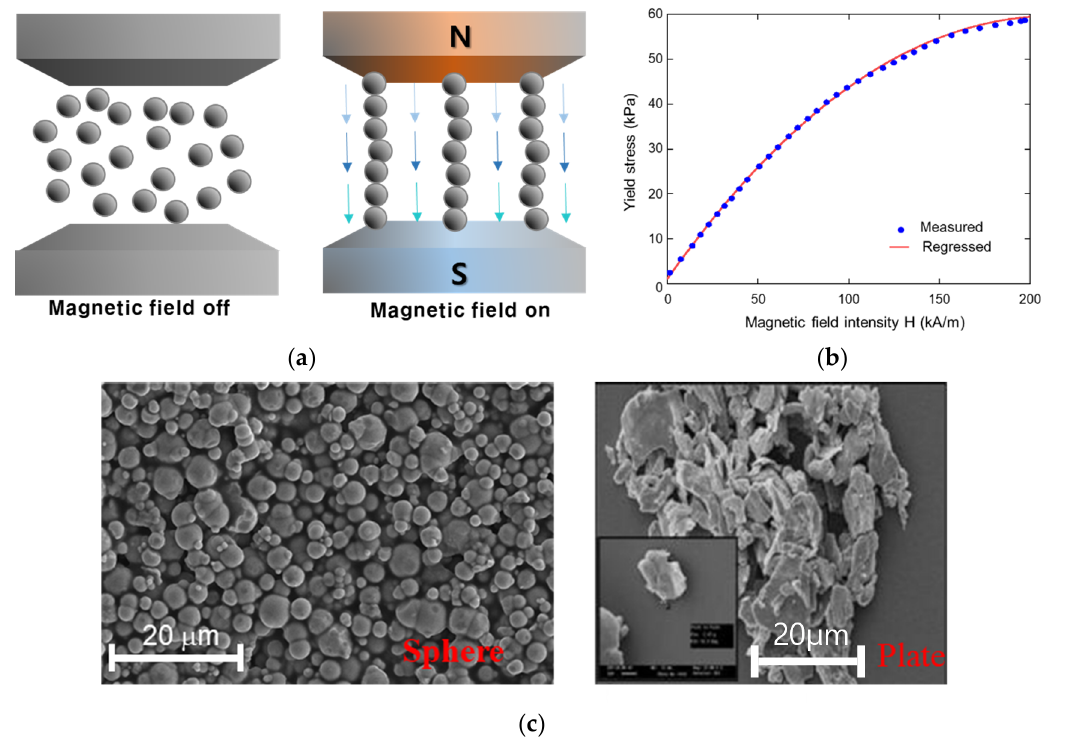
Figure 1. MR fluid: ( a ) Phenomenological characteristics; ( b ) Yield stress results; ( c ) Shape of